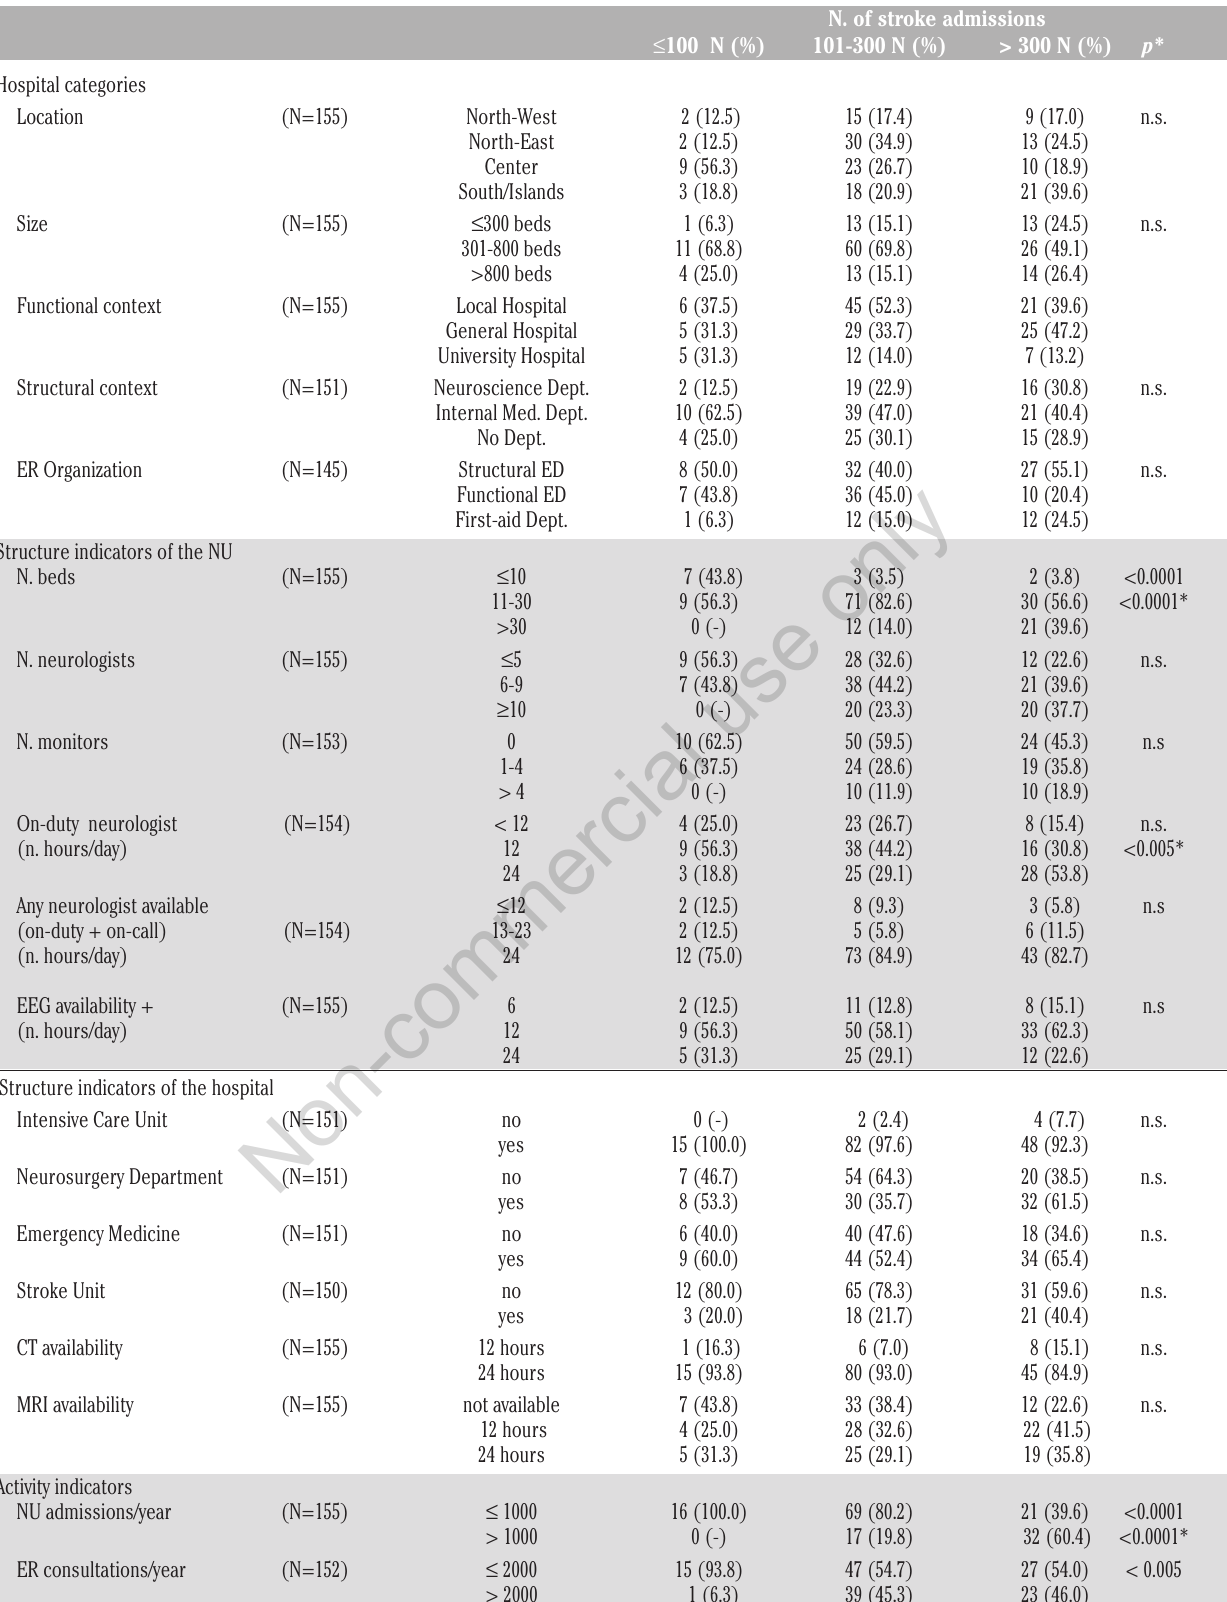
Table 1. Hospital categories and structure-activity indicators by stroke burden (number of admissions for stroke/year to each NU) (N=155).